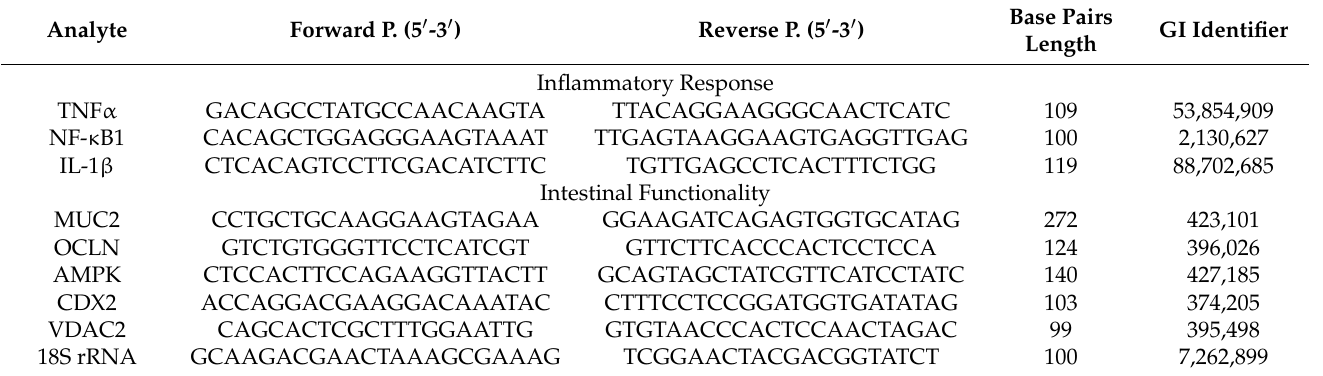
Table 1. Sequence and description of experimental